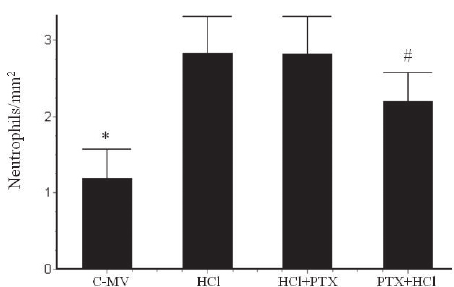
Figure 4 - Effects of PTX on morphometric counts of neutrophils in the lung tissue in the groups C-MV, HCl, HCl+PTX and PTX+HCl. * p <0.05 versus all the other groups, and # p <0.05 versus the HCl and the HCl+PTX groups. Values are presented as mean ± SD.